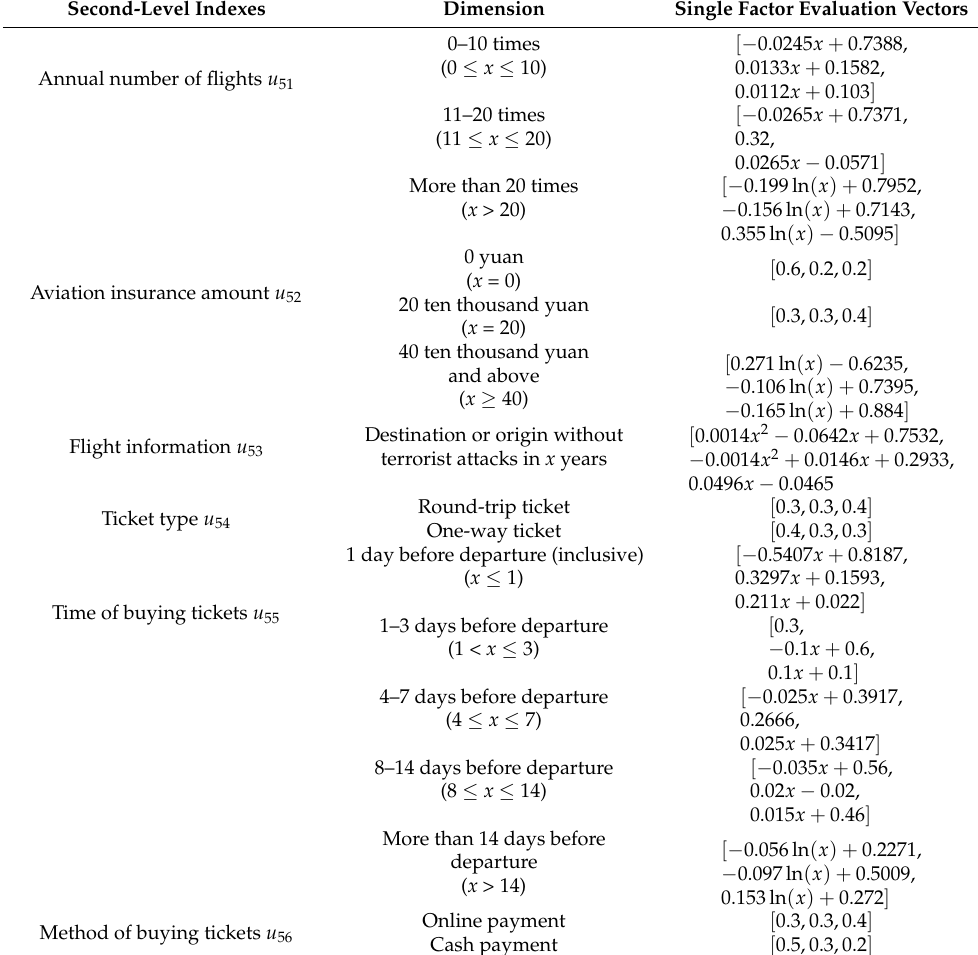
Table 13. Single factor evaluation of civil aviation travel record